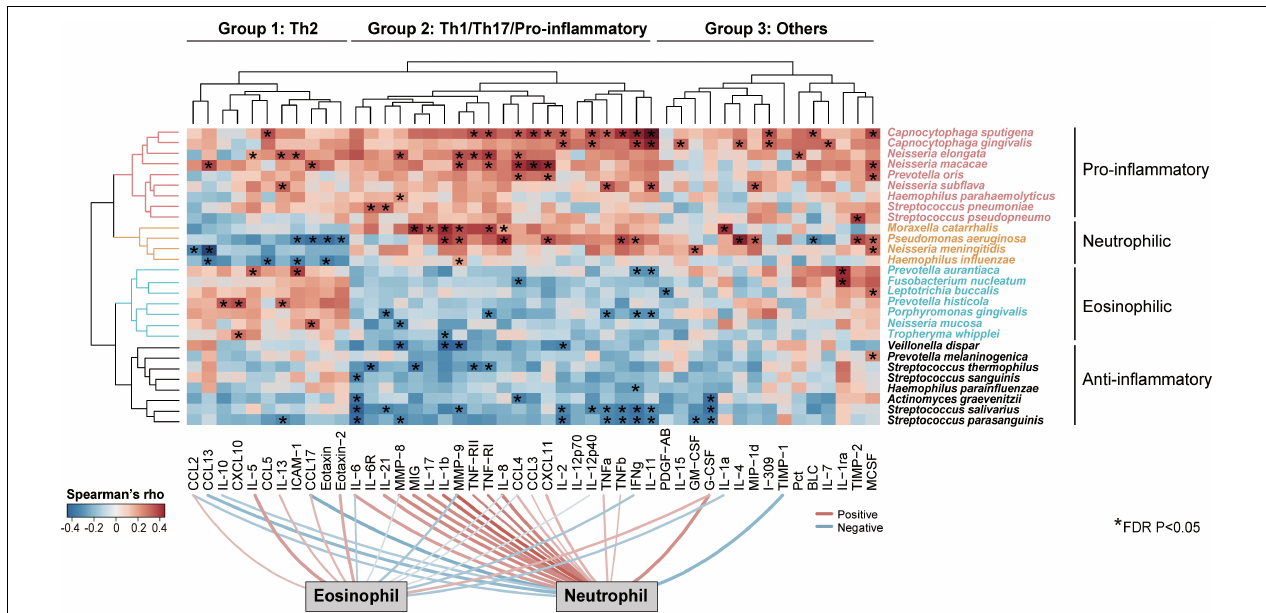
FIGURE 3 | Species-specific association of airway microbiome with inflammatory phenotypes. Unsupervised two-way hierarchical clustering analysis on an all-against-all correlation profile between species-level microbiome features and 47 sputum mediators from a subset of 59 COPD patients (Ward’s method), in which microbiome features and mediators were both clustered. The species were shown if they had relative abundance > 0.001 and were significantly associated with at least one of the 47 sputum mediators (HAllA, FDR P < 0.05). The mediators were clustered into three groups and termed based on their classes and associations with airway eosinophils or neutrophils (Group 1: Th2-related, Group 2: Th1/Th17/Pro-inflammatory-related, Group 3: Others). The microbiome features were clustered into four groups based on their association patterns with the three groups of mediators (termed “Pro-inflammatory,” “Neutrophilic,” “Eosinophilic,” and “Anti-inflammatory”). The significant associations were indicated in asterisks. Significant positive and negative associations between sputum mediators and neutrophilic and eosinophilic percentages were shown on bottom of the heatmap (FDR P <